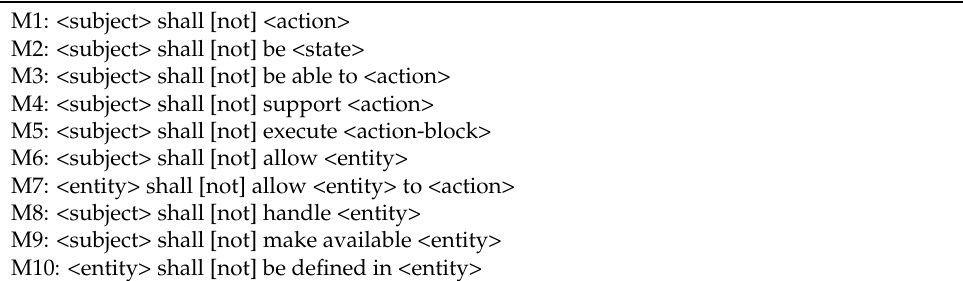
Table 3. Boilerplate Main Clauses (M k ).